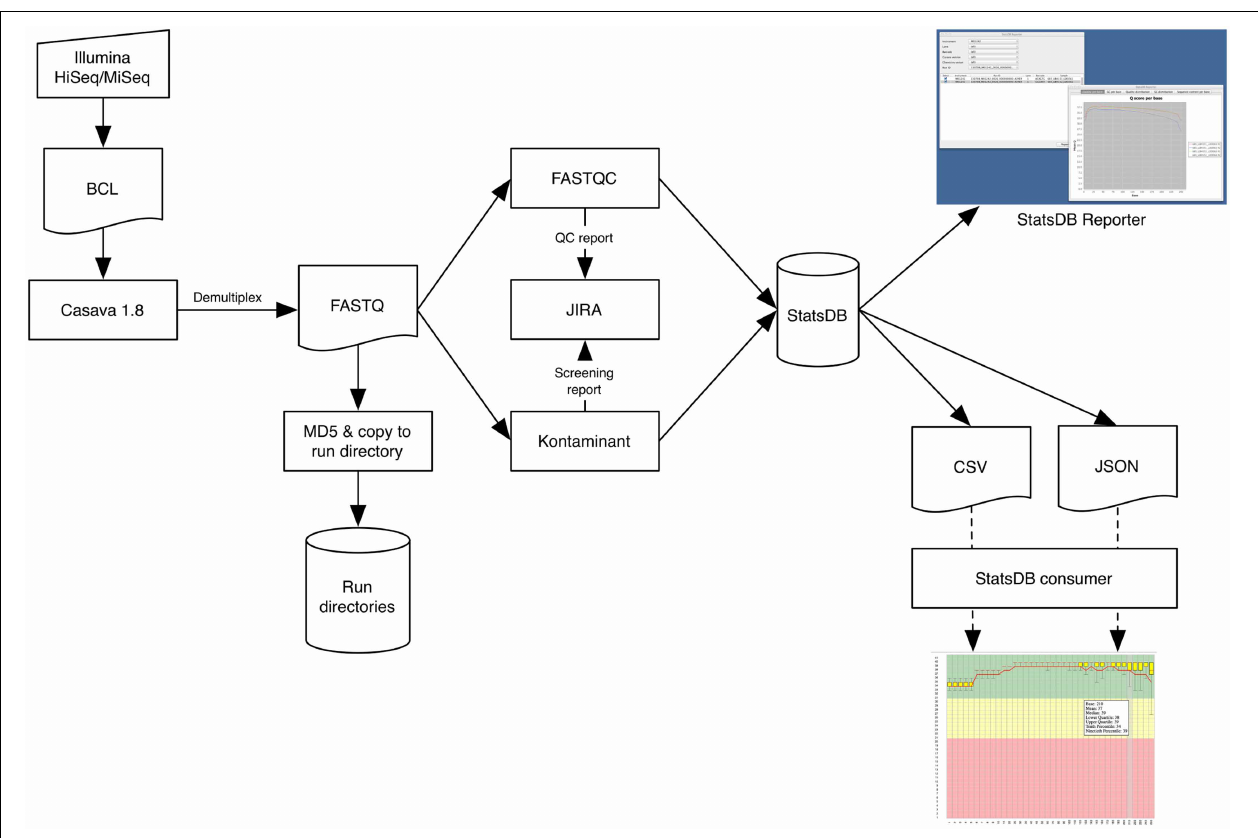
FIGURE 1 | Data flow through the Primary Analysis Pipeline, focused on the Illumina